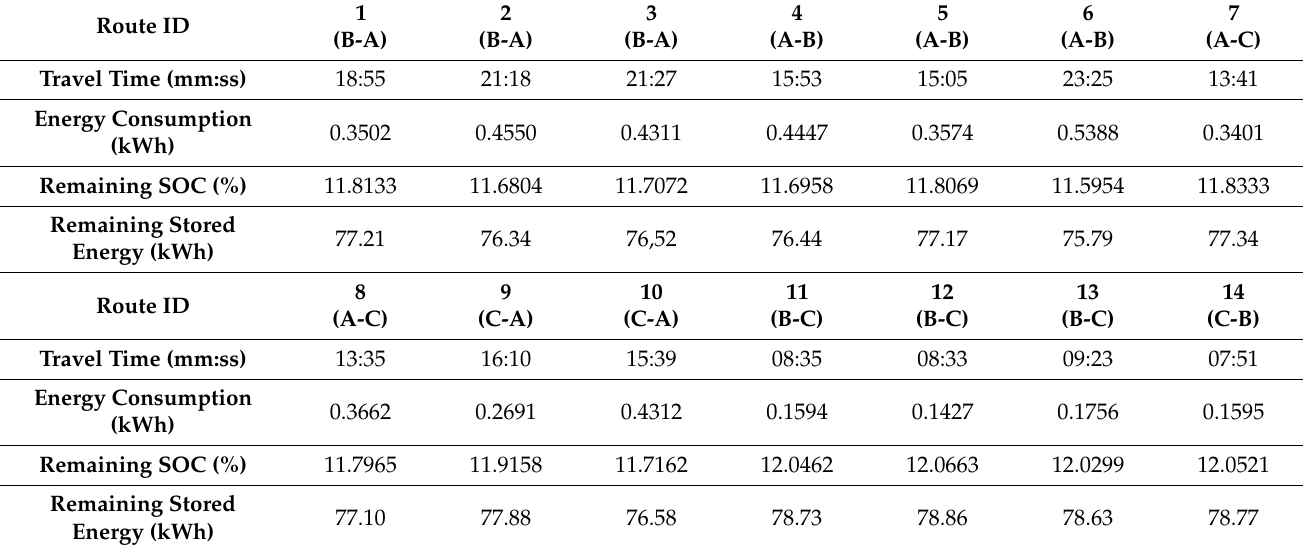
Table 3. Performance indicators of EV—type